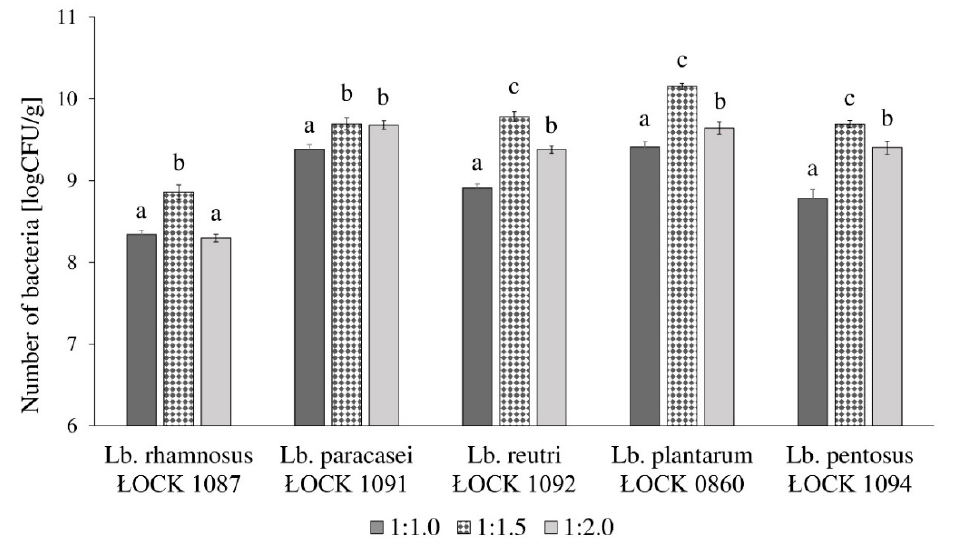
Figure 1. Growth performance of five Lactobacillus spp. (abbreviated as Lb. ) in the semi-solid fermentation (SSF) medium, with three different water contents, in which the ratio of flours to water was as follows: 1:1.0, 1:1.5, and 1:2.0. Ł OCK is a designation of strains obtained from the Lodz